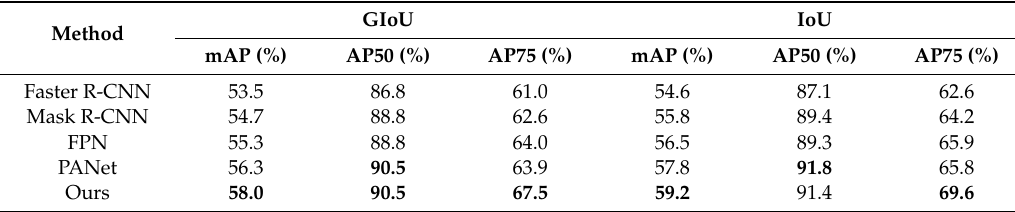
Table 2. Comparison with four state-of-the-art methods on NWPU VHR-10 dataset in terms of six evaluation metrics. Bold fonts denote the best results.